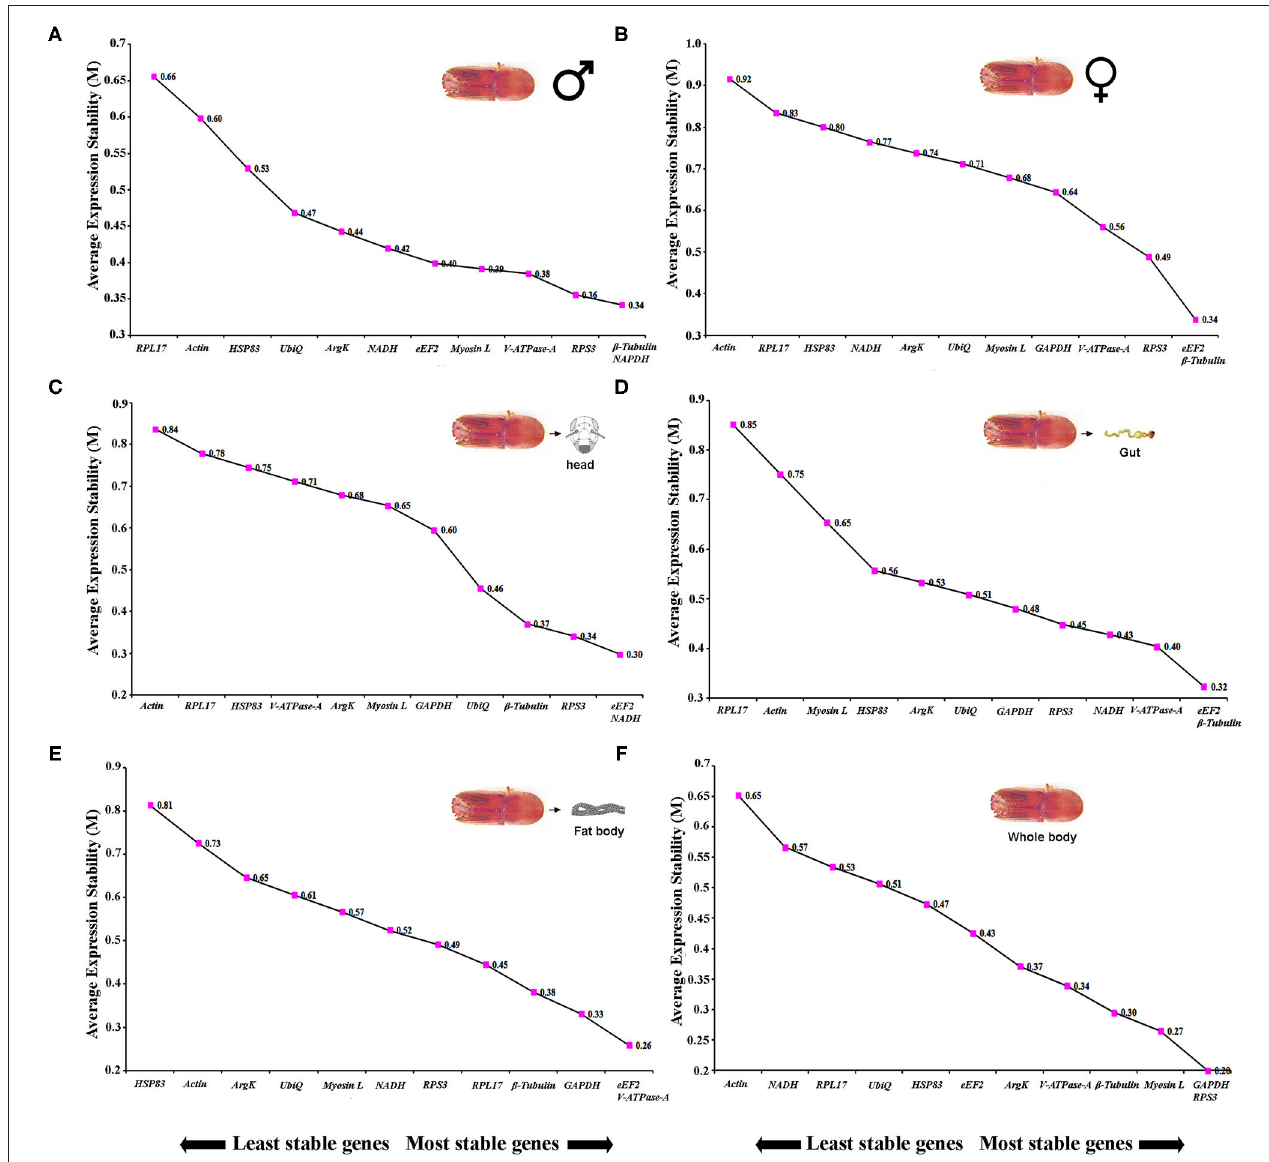
FIGURE 2 | The average expression stability values (M) of 12 reference genes under different conditions (sex-specific and tissue types) were calculated by geNorm from the least stable (left) to the most stable (right). (A) male, (B) female, (C) head, (D) gut, (E) fat body, and (F) whole body